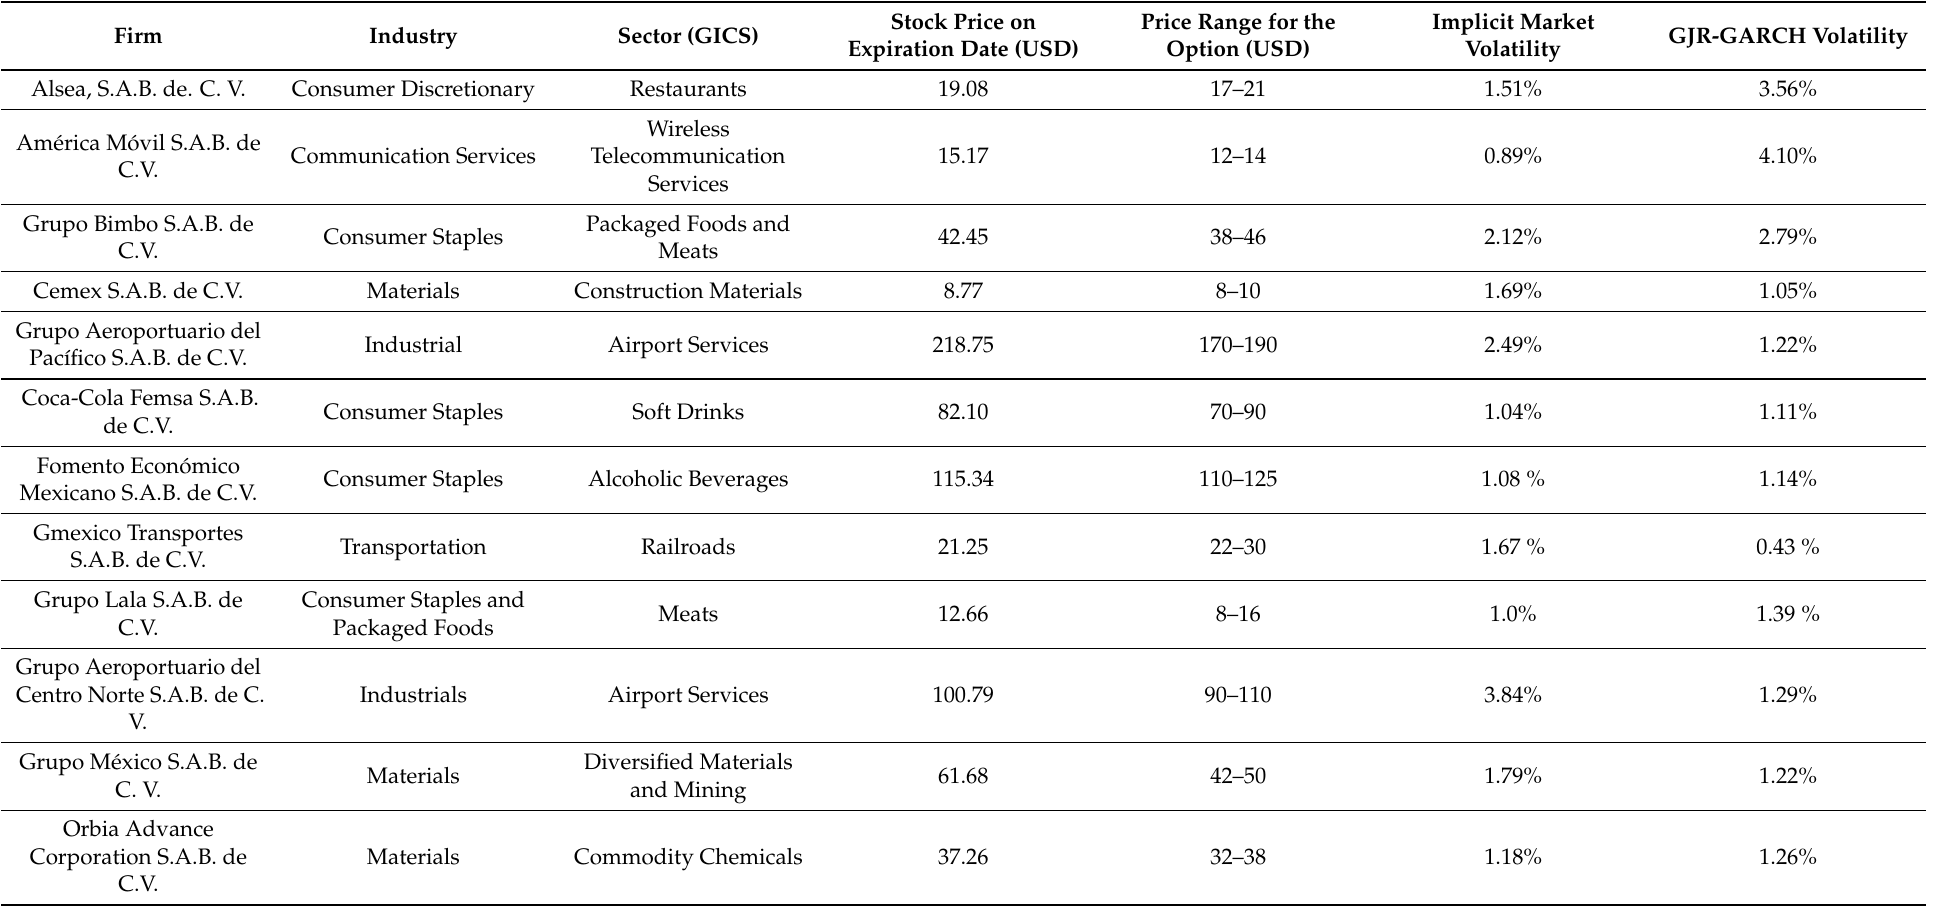
Table 2. Descriptive facts and volatility statistics for each